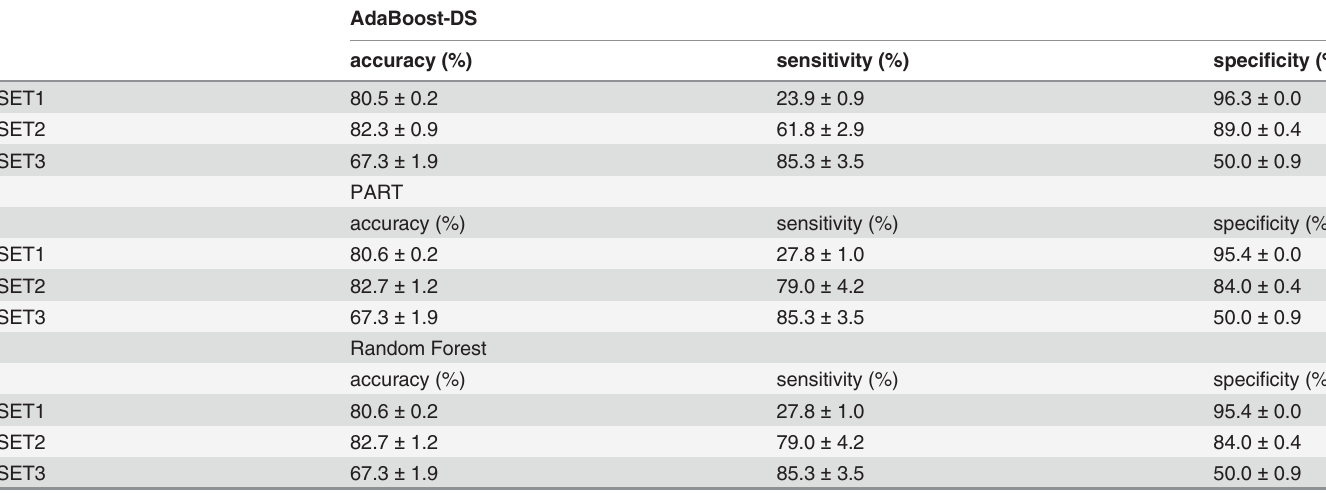
Table 8. Performance measures for the AdaBoost-DS, PART, and Random Forest algorithms.